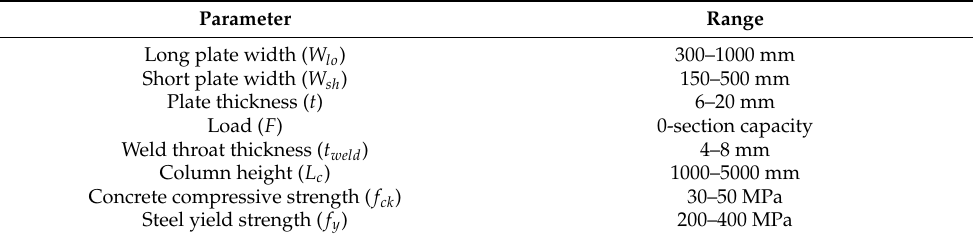
Table 6. Parameters range.